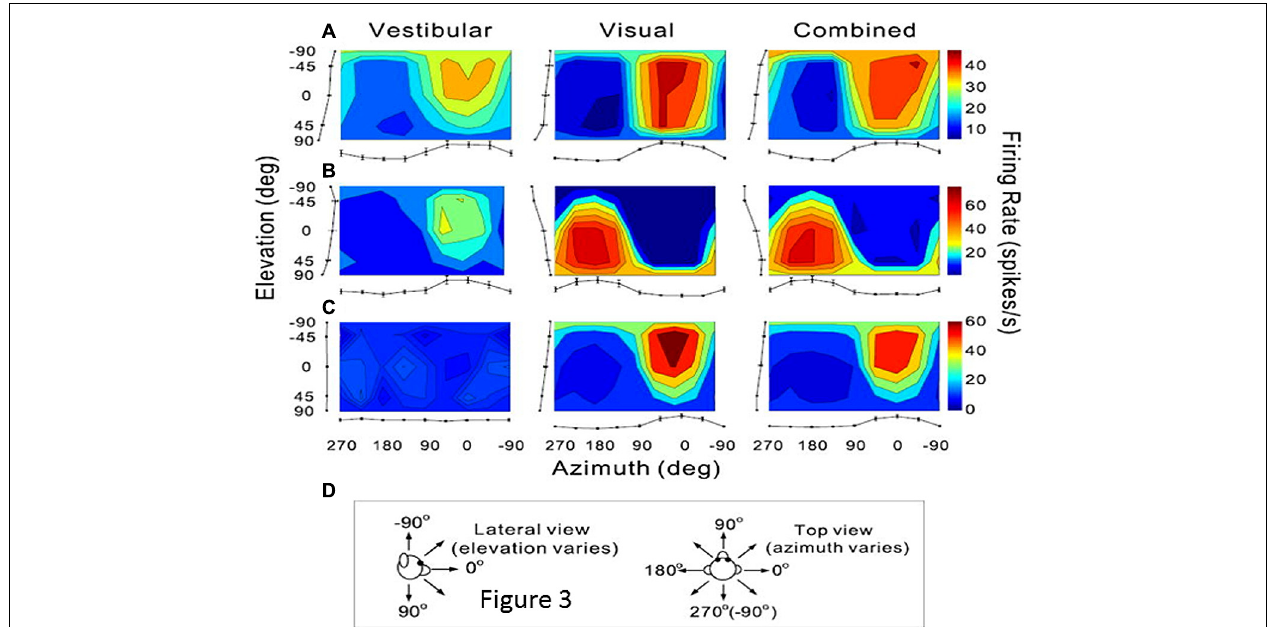
computed in azimuth and elevation angles. (D) Representations of the 3D heading directions in azimuth and elevation angles. (A) Neuron with congruent tuning for heading elicited by vestibular and visual cues. (B) Neuron with incongruent tuning for heading elicited by vestibular and by visual cues. (C) Neuron with selective tuning for visual heading only. Reproduced from Gu etal.